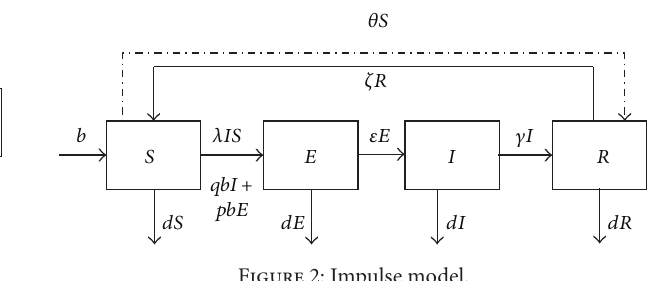
Figure 2: Impulse